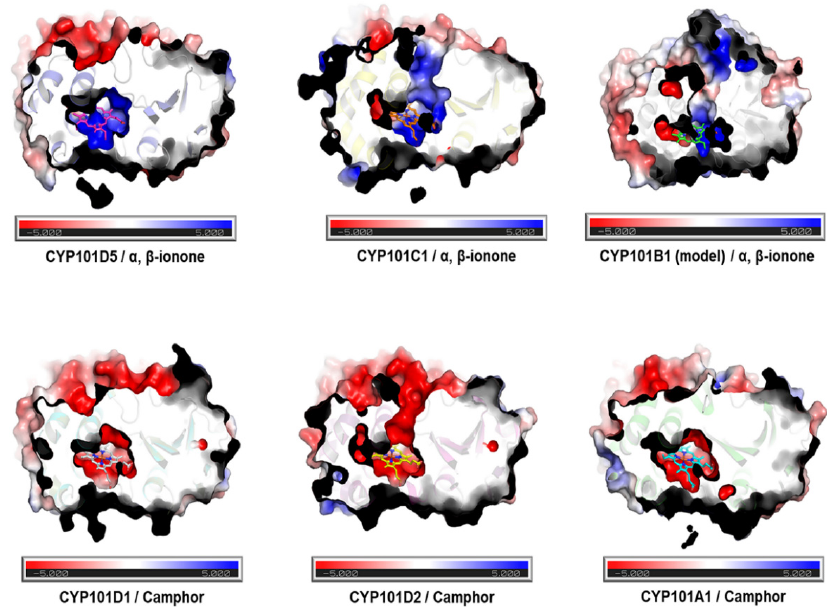
Figure 8. Surface charge distribution of the CYP101 family members. Red represents negatively charged regions (scale of − 5), blue represents positively charged regions (scale of +5), and gray represents neutrally charged regions. The ionone-binding CYPs show the distribution of positive charges, especially surrounding the heme molecule and substrate binding site, while camphor-binding CYPs are mostly negative at the substrate binding site, including the substrate